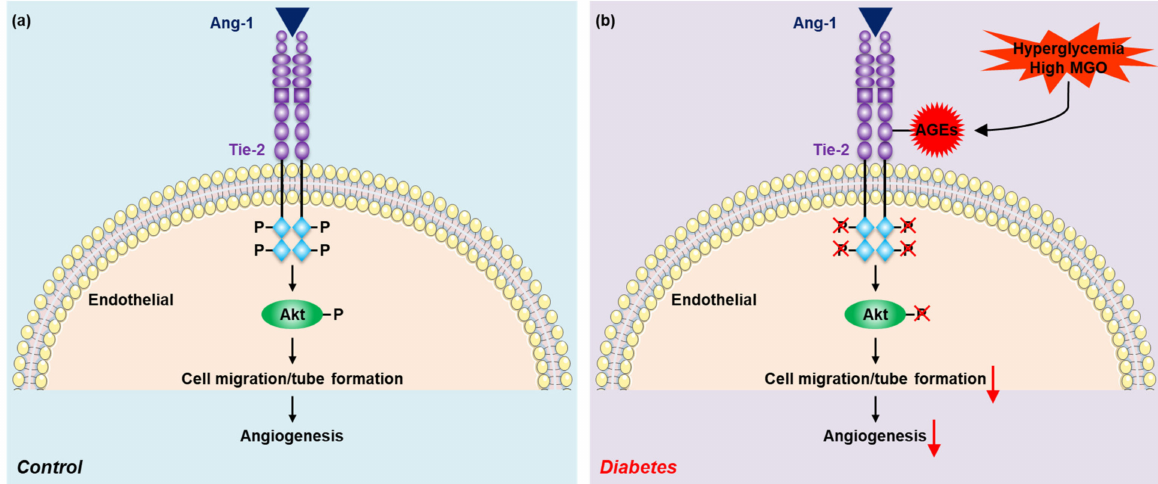
Figure 6. The molecular mechanism underlying Tie-2 glycation–regulated Ang-1 signaling and Ang-1–induced angiogenesis. ( a ) Under the physiology condition, the binding of Ang-1 to Tie-2 induces Tie-2 and Akt activation, causing endothelial cell migration and tube formation, consequently leading to angiogenesis. ( b ) However, hyperglycemia or high MGO in diabetes mellitus induces AGEs–Tie-2 adduct formation (Tie-2 glycation), which inhibits Ang-1 signaling activation and Ang-1- induced